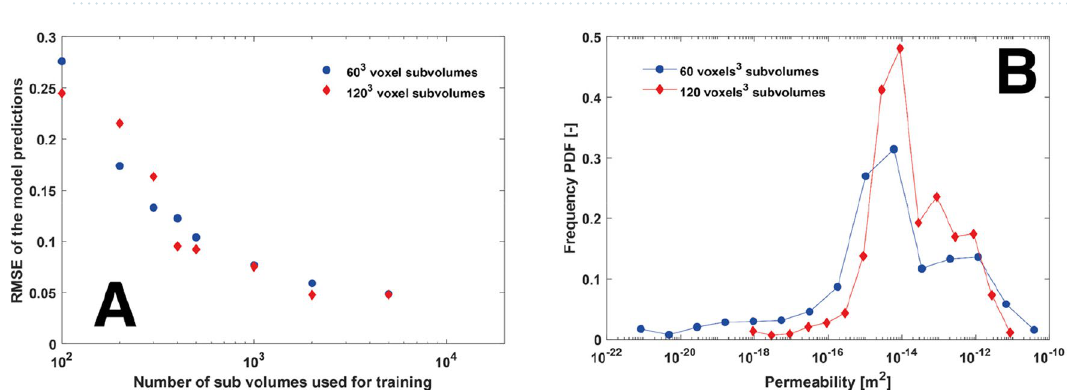
Figure 4. ( A ) The RMSE of the model predictions with size of subvolume for both 60 3 and 120 3 subvolumes vs the number of subvolumes in the training dataset. ( B ) The PDF of ground truth (DBS) permeabilities for both 60 3 and 120 3 voxel sized sub-volume datasets. Data in this figure was computed using OPENFoam 46 and SciKitLearn 41 and rendered using MATLAB 48